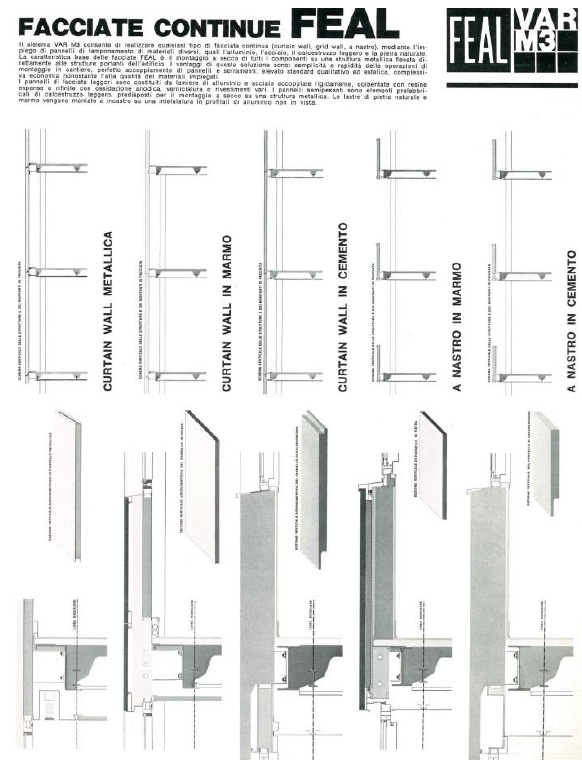
Figure 4: an advertising of a prefabricated envelope produced by Feal in the seventies.